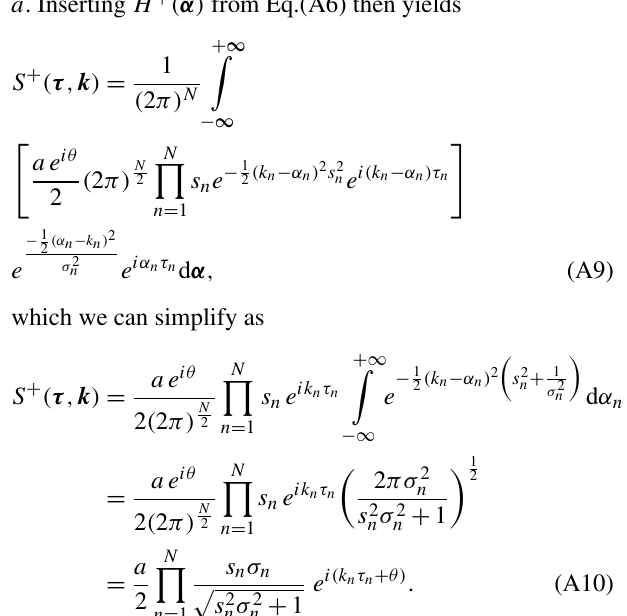
Figure A1. (a) Theoretical peak measurable amplitude a out in each dimension n for an N -dimensional Gaussian wave packet with peak amplitude a = 1, wavelength λ n and standard deviation s n in the one-, two- and three-dimensional Stockwell transforms (with scale factor c n ). The x axis shows the number of wave cycles per two standard deviations β n = 2 s n (b) shows the peak measured amplitude for wave packets as isosurfaces in 3-D for the 3DST with c n = 0 . 25. To summarise, the more wave cycles in a wave packet in each dimension, the better the amplitude measurement. Adjusting the scaling parameter c n can also improve